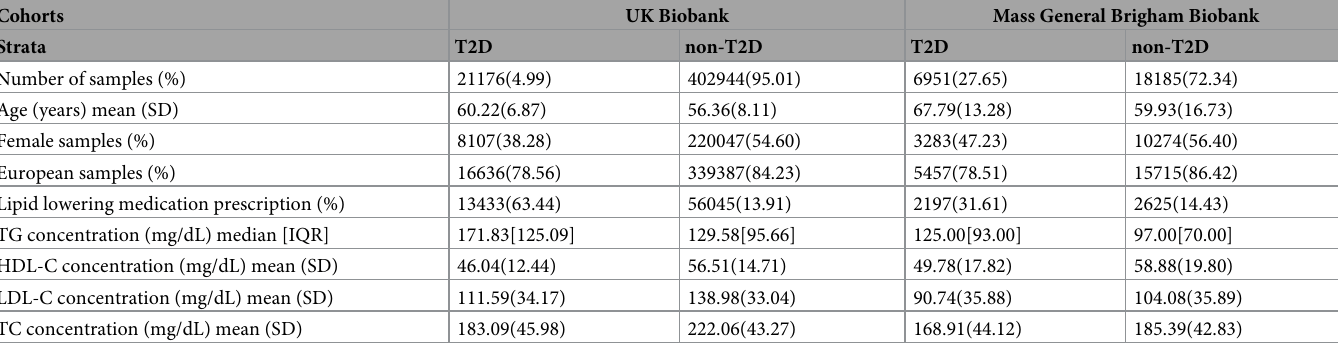
Table 1. Baseline characteristics for discovery and replication cohorts. Distribution of samples across the T2D strata in discovery (UKB) and replication (MGBB) cohorts are provided. Number of samples by gender, ancestry and lipid lowering medications are documented. Lipid measurements for the four main lipid class is tabu- lated based on T2D strata.